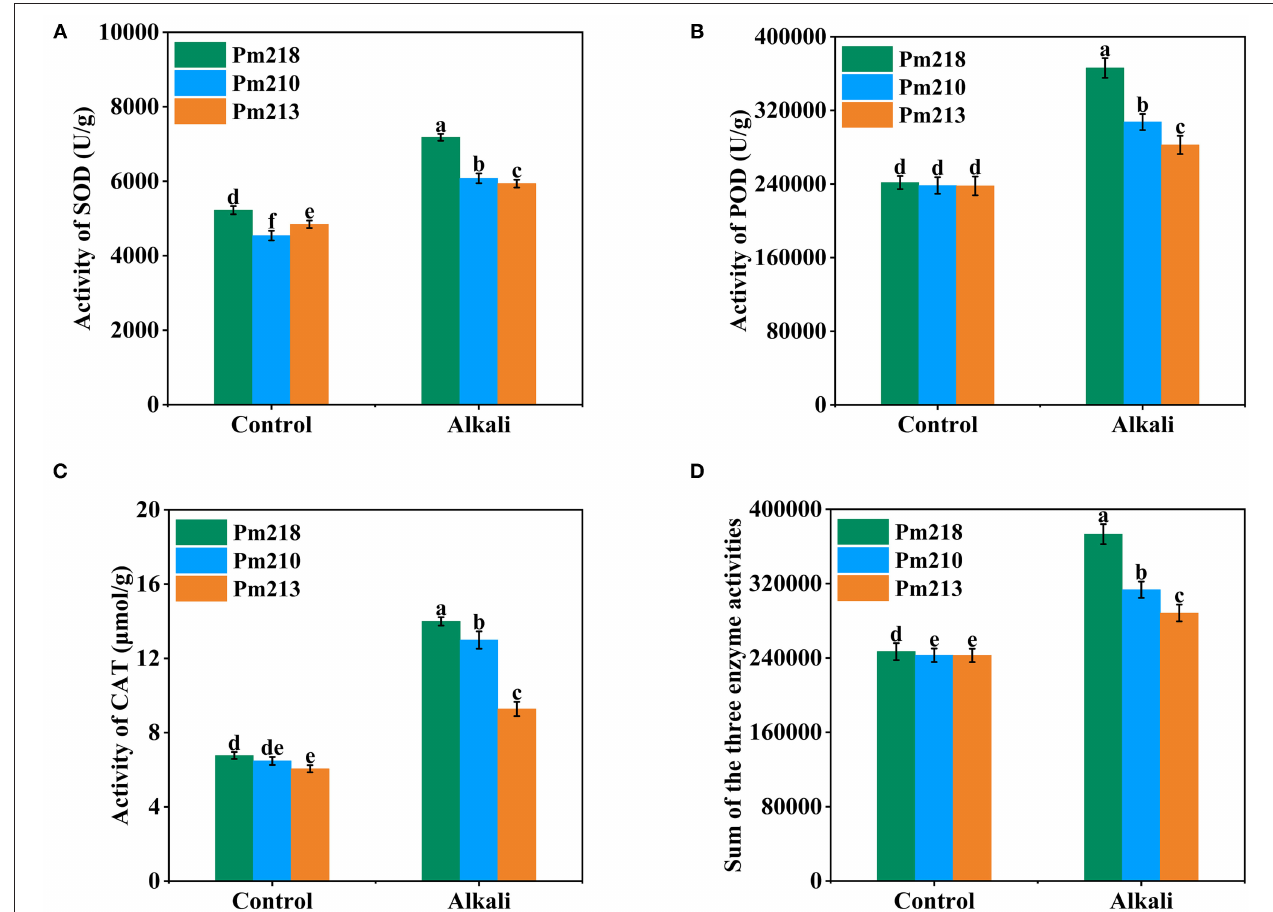
FIGURE 5 | Enzyme activities of three genotypes under control (CK) and alkali stress in seedling leaves. (A) Superoxide dismutase activity. (B) Peroxidase activity. (C) Catalase activity. (D) Sum of the three enzyme activities. Different letters indicate significant differences ( P <